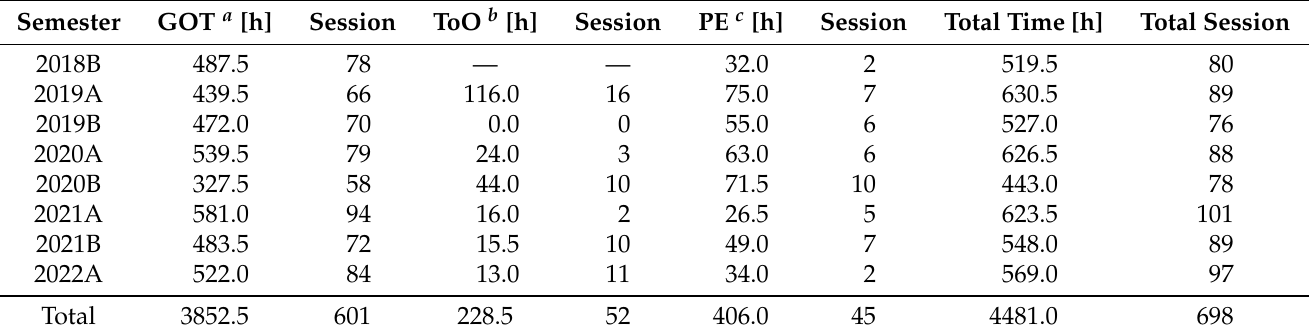
Table 6. Total observing time of EAVN for each